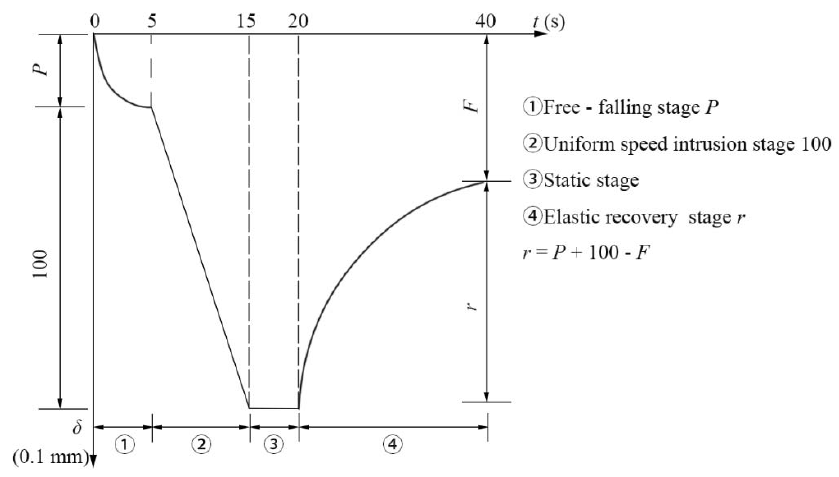
Figure 3. ( a ) Standard cone; ( b ) penetrating the ball; ( c ) mold and tripod.